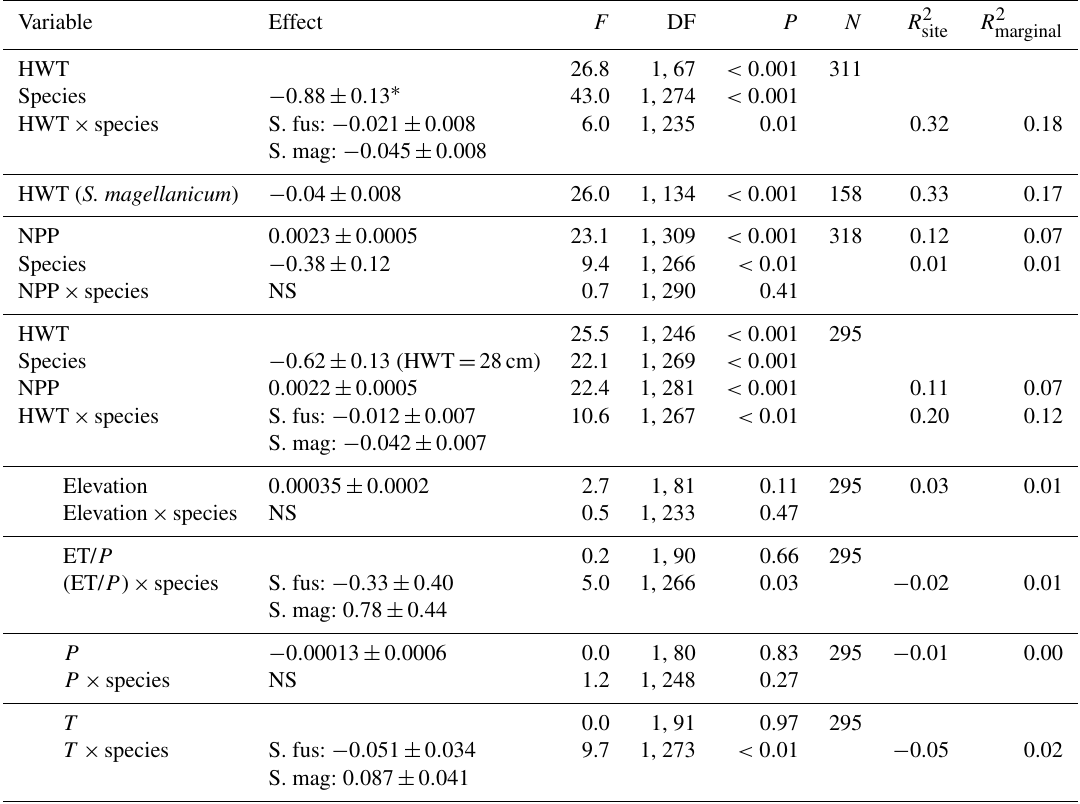
Table 2. Results from linear mixed models for δ 13 C values. Statistical tests are based on type-2 F test using Kenward–Roger-adjusted degrees of freedom. The second model only included S. magellanicum . Elevation (ma.s.l.) and the three climatic variables (growing season sums and means: ET/ P , P in millimetres, temperature in degrees Celcius) were tested one by one in the model including HWT (height above the water table in centimetres), species and NPP (gm − 2 yr − 1 ). For simplicity, the negligible HWT × NPP term was dropped from this model ( P = 0 . 36). Estimated effects ( ± SEs) are only given for the main effects if interactions were considered negligible. These effects are slopes for continuous variables (all variables except species) and for species (categorical) the difference between S. magellanicum and S. fuscum (i.e. S. fuscum being the reference level). In the presence of an interaction between HWT and species, the species effect was estimated at mean HWT. R 2 is explained between-site variance; R 2 is explained total site marginal